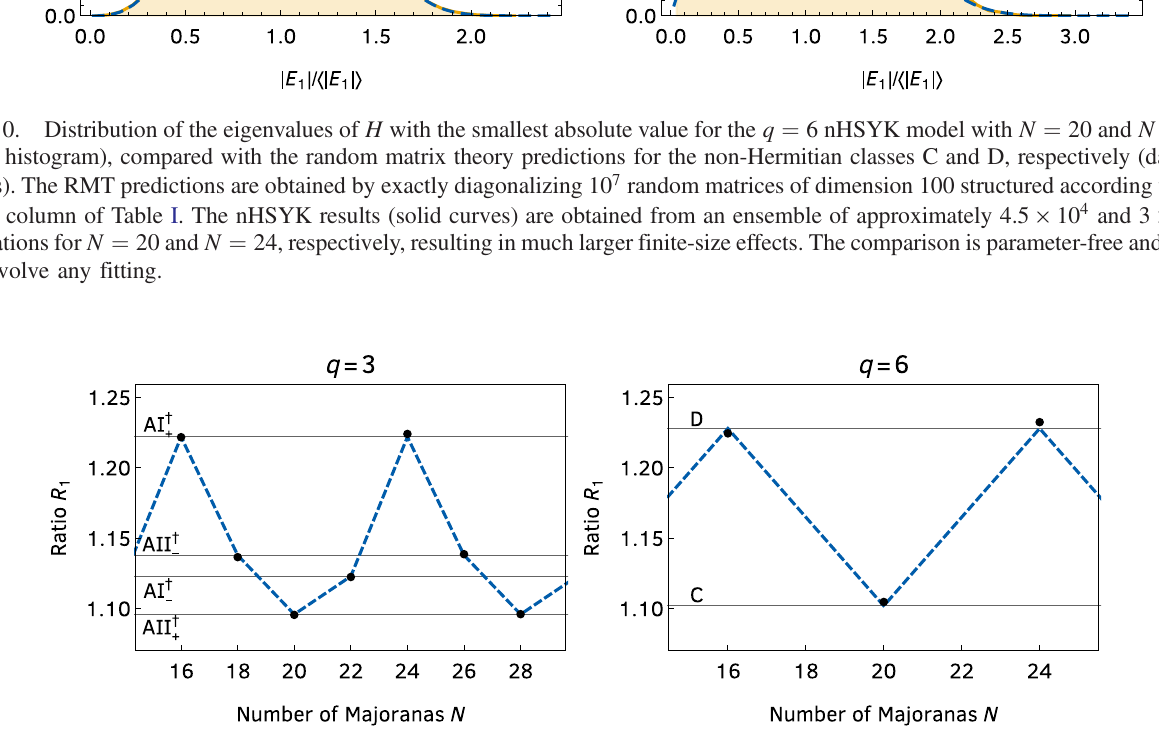
FIG. 11. Ratio R 1 in Eq. (18) as a function of the number of Majoranas, N , for the q ¼ 3 and the q ¼ 6 nHSYK model. The dots are the results of exact numerical diagonalization of the correspondingnHSYK Hamiltonian, the horizontal solid lines are thevalues of the ratio for the six classes with spectral inversion symmetry realized in the nHSYK model, and the dashed curves follow the classification scheme of Table II. For q ¼ 3 , the Hamiltonian has a chiral symmetry for all even N , while for q ¼ 6 , there is a particle-hole symmetry only if N is a multiple of 4. We see excellent agreement between the nHSYK results and the RMT predictions for all available system